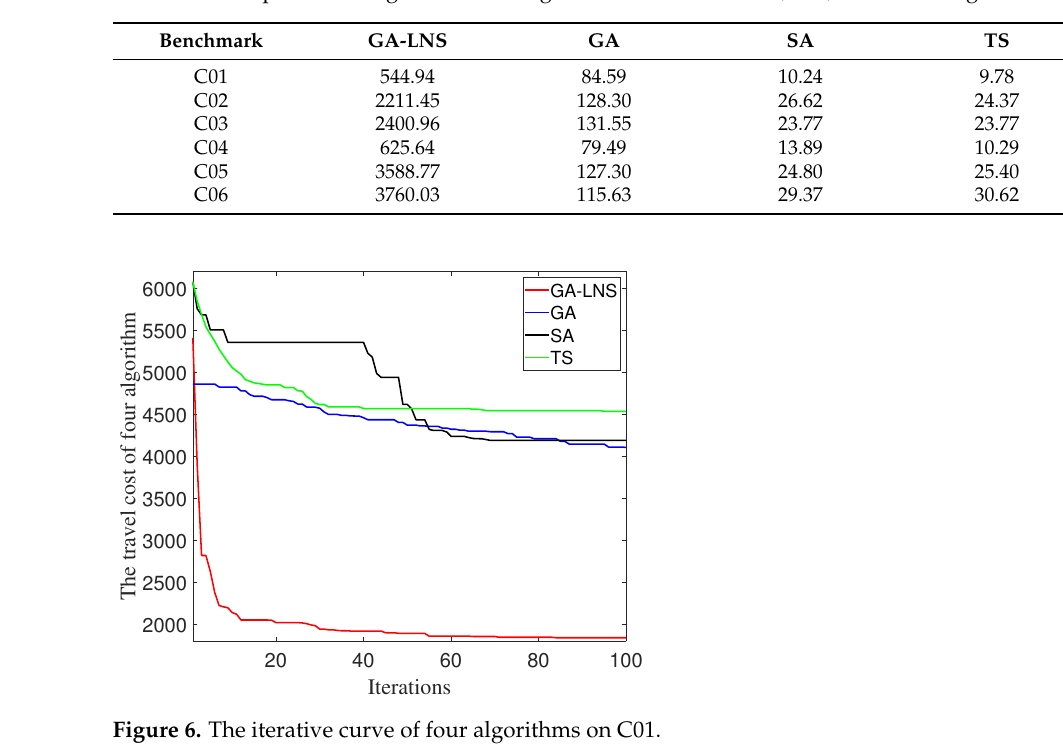
Table 4. A comparison of algorithm running time with the GA-LNS, GA, SA and TS algorithm.